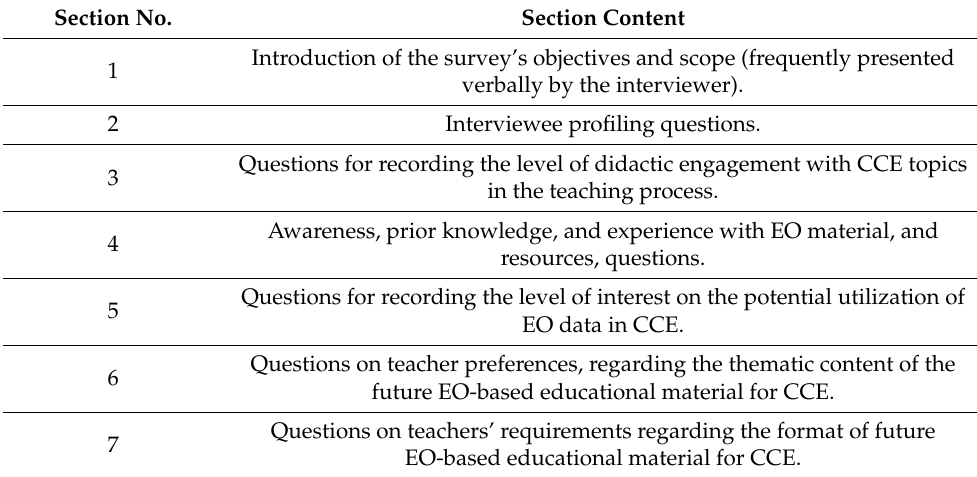
Table 1. Overview of the interview guide structure used to record participants’ responses. Section